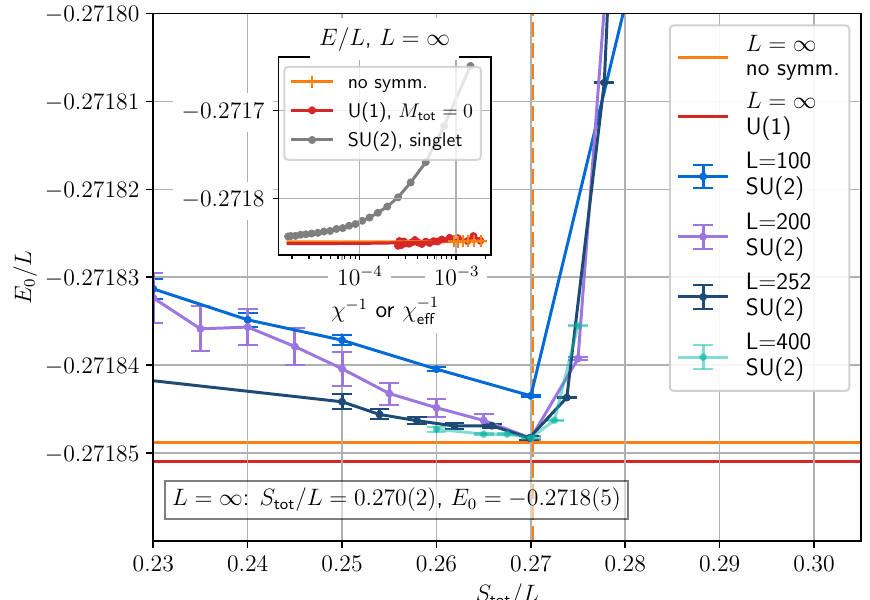
Figure 2: Lowest energies of the sawtooth chain with J = − 1, J ′ = 1 in various sectors of the total spin S for finite systems, obtained using the SU(2)-symmetric tot DMRG with periodic boundary conditions. The lowest energy among the sectors is compared with the infinite-system (VUMPS) calculations, where one cannot target a / L com- specific sector of S (horizontal lines). The vertical dotted line shows S tot tot puted according to Eq. 8 for the infinite system without symmetries. The respective bond dimensions can be found in Tab. 1, and the estimation of error bars is outlined in App. A.1. The inset shows the energy of the infinite system as a function of the inverse (effective) bond dimension χ − 1 (solid lines are inter / extrapolations). The ( eff ) two-site variance for the infinite system [ 45 ] is of the order of 10 − 5 (no symmetries), 10 − 4 [ U(1) ] and 10 − 3 ∼ 10 − 4 [ SU(2) ]